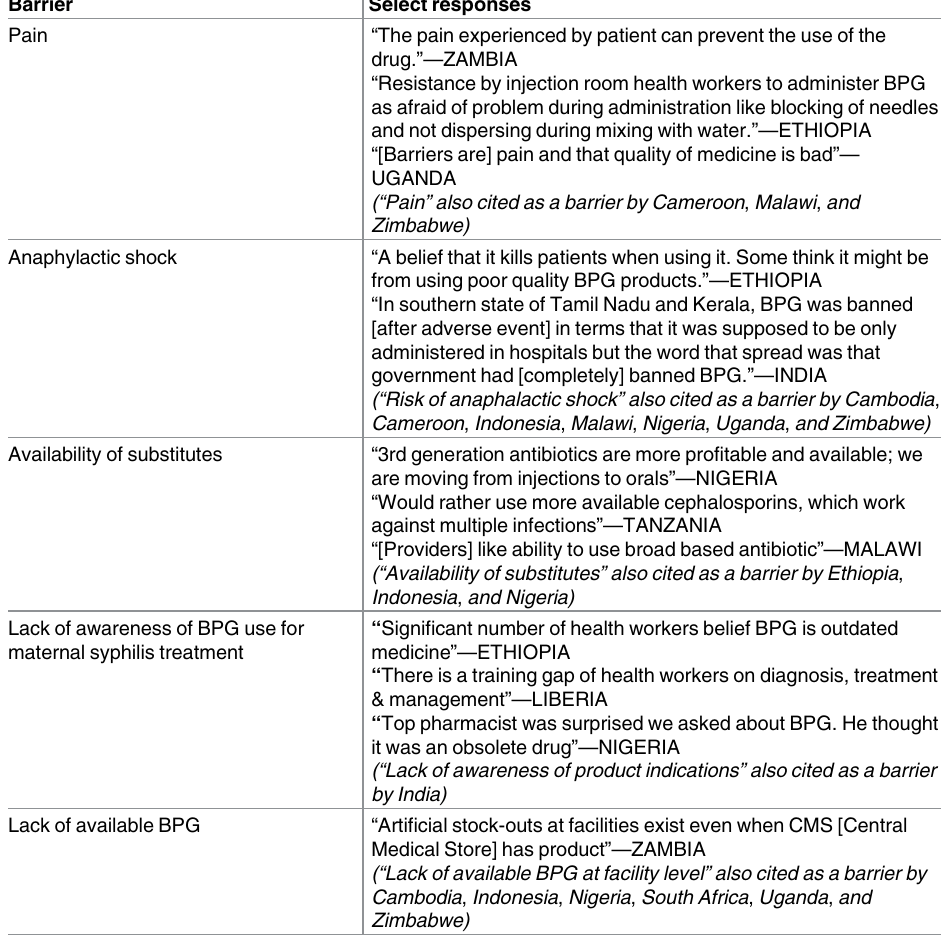
Table 3. Select responses from providers describing barriersto administration of